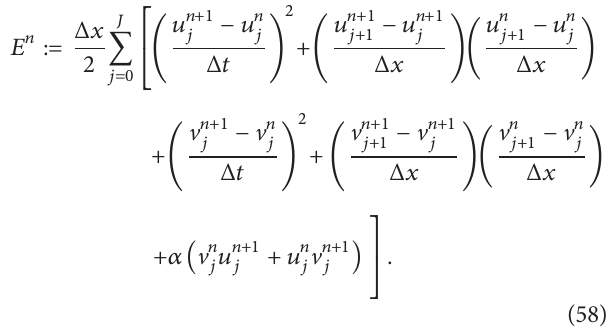
Figure 1: 𝛽 1 = 1 , 𝛽 2 = 1 .